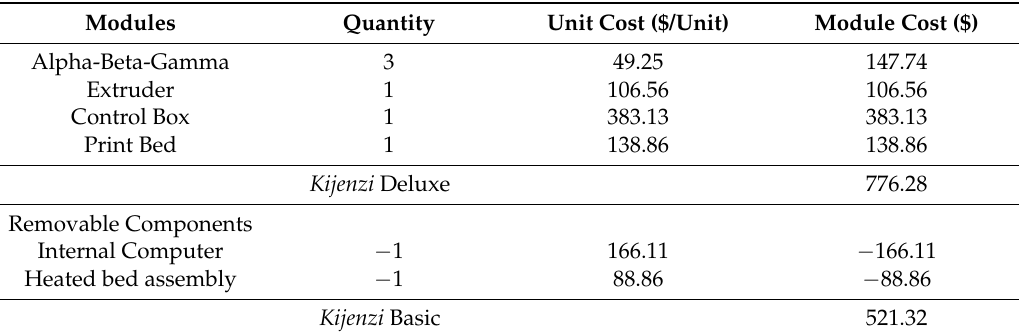
Table 2. Kijenzi 3-D printer modules costs to fabricate the basic and deluxe